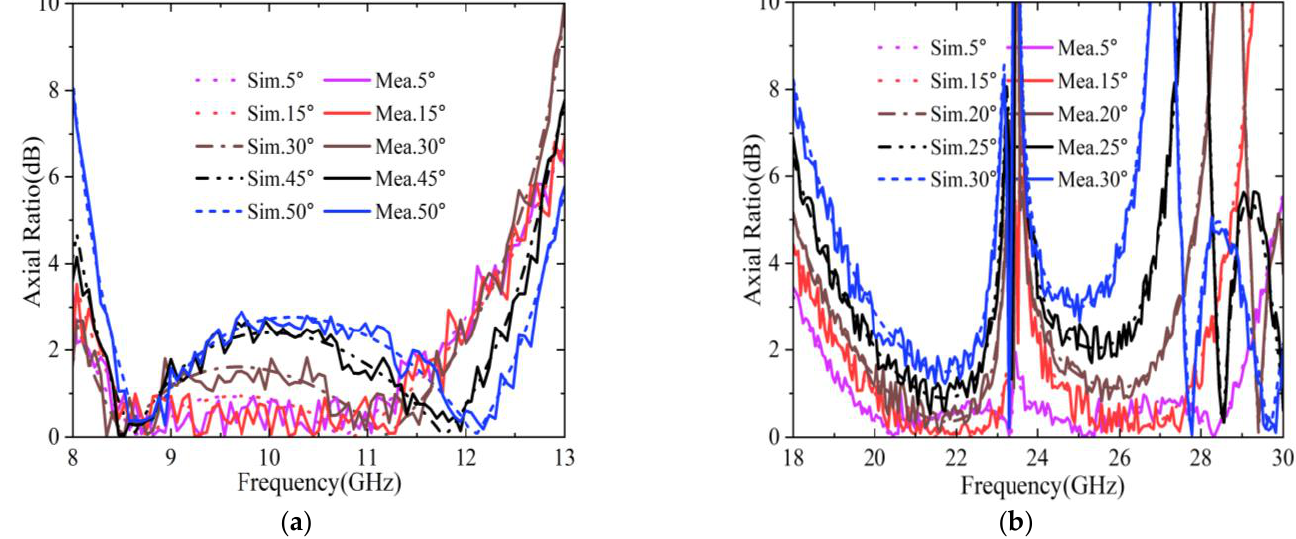
Figure 12. Measured and simulated axial ratios in: ( a ) The lower band; ( b ) The higher band.